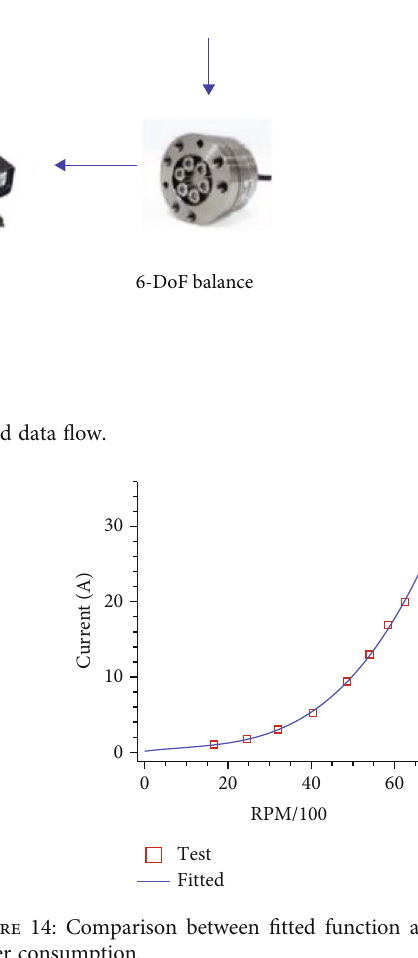
Figure 14: Comparison between fi tted function and test data of power